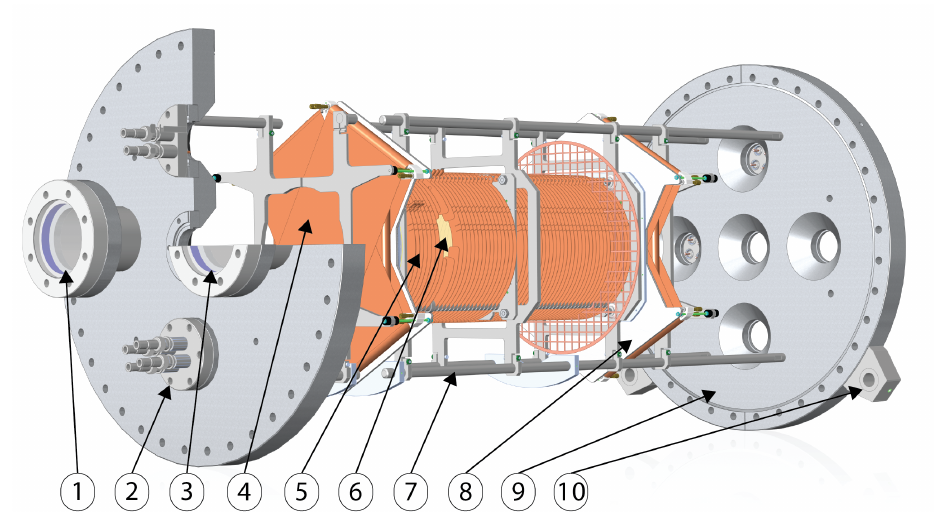
Figure 3. The DREAM spectrometer; indicated are the optical laser out-coupling (1), the detector HV feedthroughs (2), the optical laser in-coupling (3), the 120 mm delay line detector (4), the spectrometer blades with an inner diameter opening of 120 mm (5), the opening for the X-rays and optical laser (6), the spectrometer rail and support frame (7), the second 120 mm delay line detector (8), the second spectrometer flange (9), and the installation support rail guiding (10).